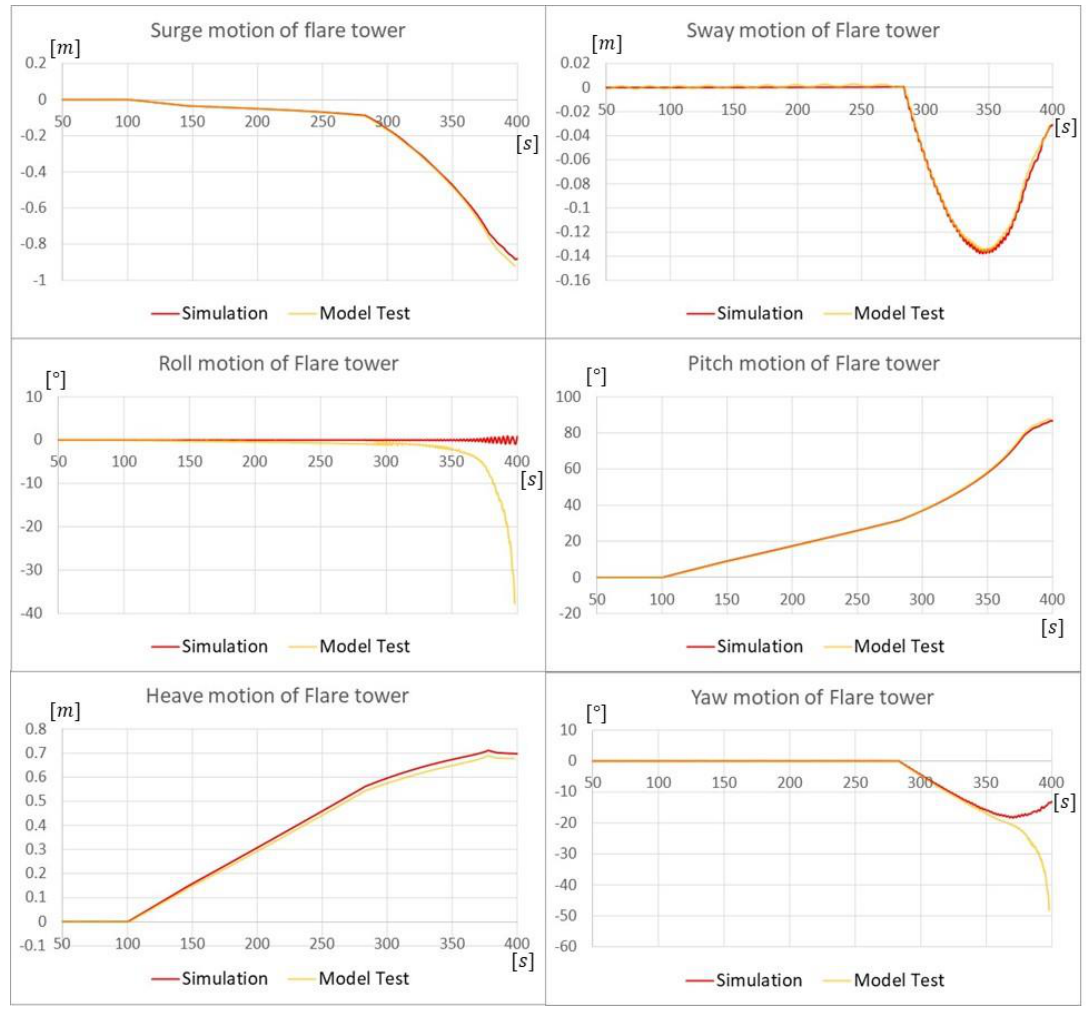
Figure 19. Comparison of flare tower motion.